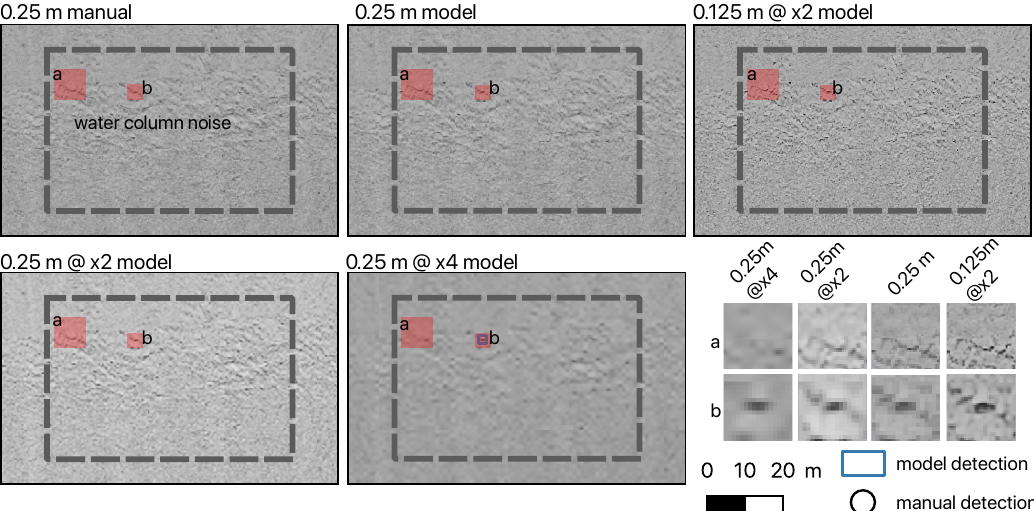
Figure 11. Subsets of the native and upscaled mosaics in an area affected by water column stratification artefacts. Insets detail the appearance of the water column artefacts in the different